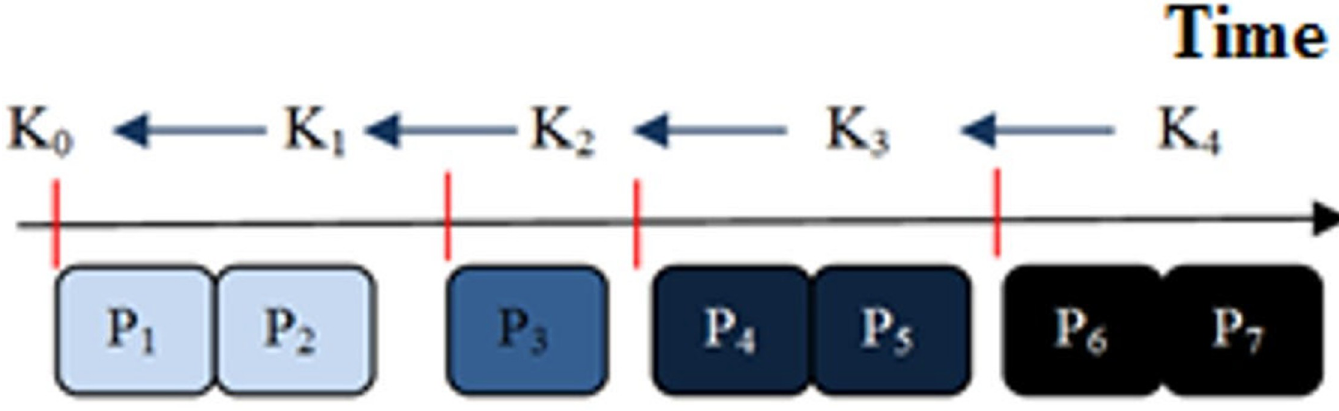
Fig 5. Encrypting and decrypting packets with one-way function keys